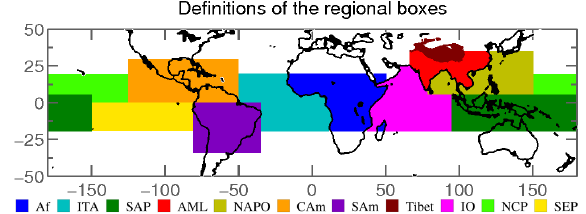
Figure 1. Distribution of the geographical regions within the trop- ics and the subtropics. In color: Africa (Af), Intertropical At- lantic (ITA), South Asian Pacific (SAP), Asian mainland (AML), North Asian Pacific Ocean (NAPO), Central America (CAm), South America (SAm), Tibetan Plateau (Tibet), Indian Ocean (IO), North Central Pacific (NCP) and Southeast Pacific (SEP). Tibet is defined as the region in Asia above